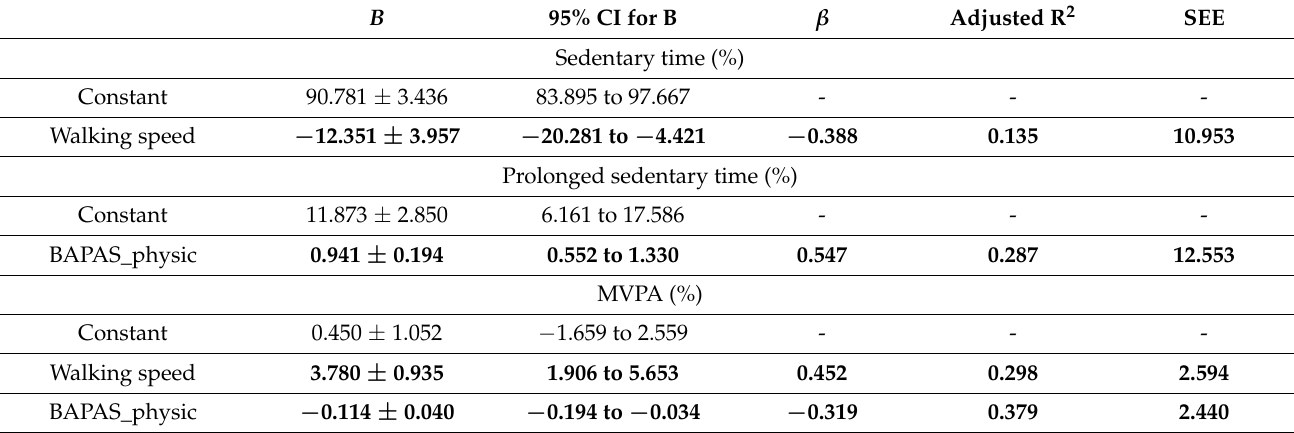
Table 4. Factors influencing sedentary behavior and physical activity—stepwise multiple linear regression analyses ( n = 57). B 95% CI for B β Adjusted R